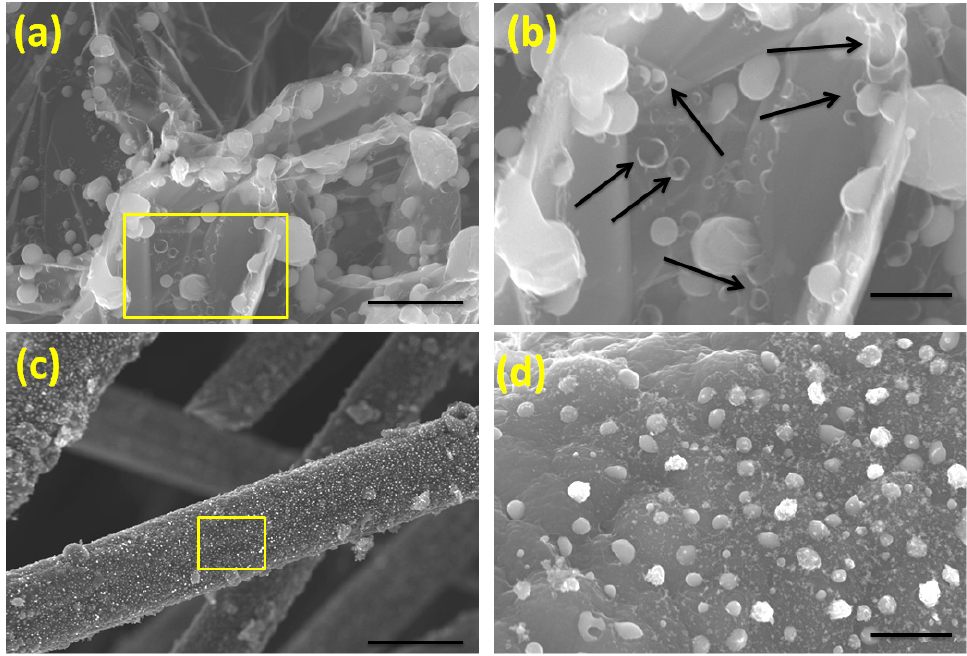
Figure 2. Morphology of carbon nanostructures obtained by pyrolysis of DABCO MOF-decorated graphene ( a , b ) and carbon fibers ( c , d ) in a traditional convection oven at 800 °C for 30 min. Scale bars are 2 µm, 500 nm, 10 µm, and 200 nm in ( a – d ), respectively.